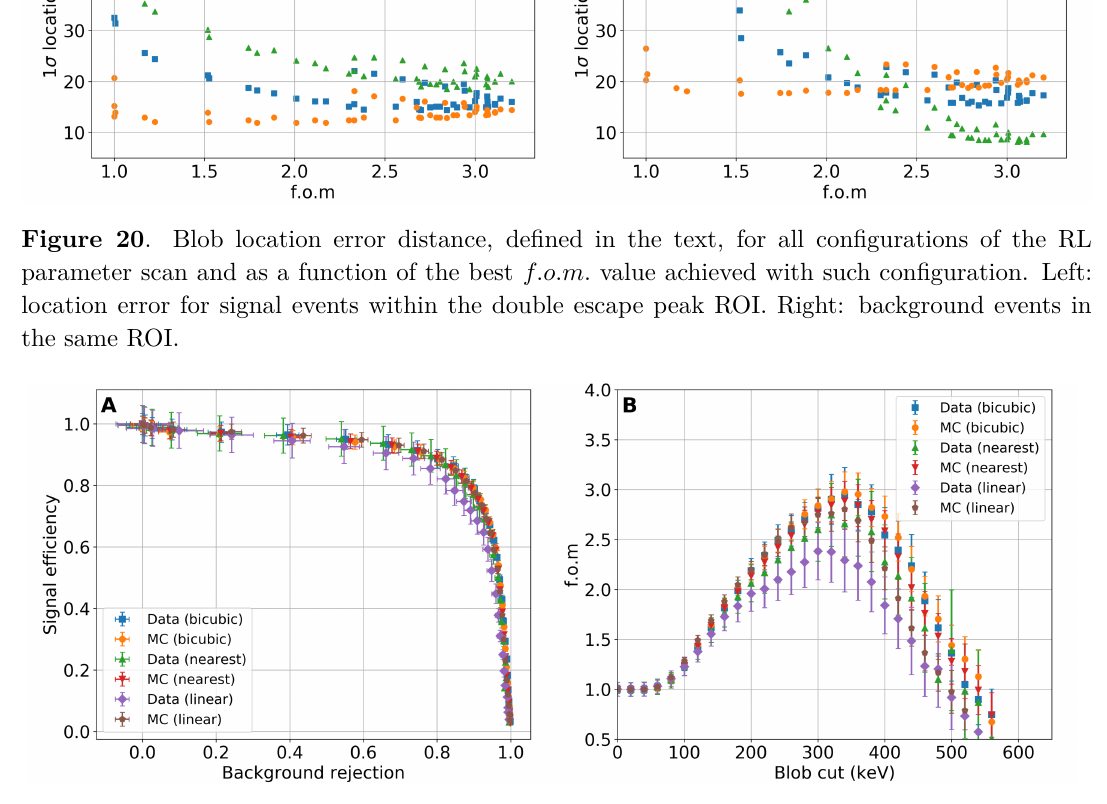
Figure 21 . Comparing different interpolation approaches for NEXT-White data and MC (using the fit), for the optimal choice of RL parameters. (A) Signal efficiency vs. background rejection for 1.6 MeV double escape peak events. (B) The figure of merit for each dataset as a function of the blob2